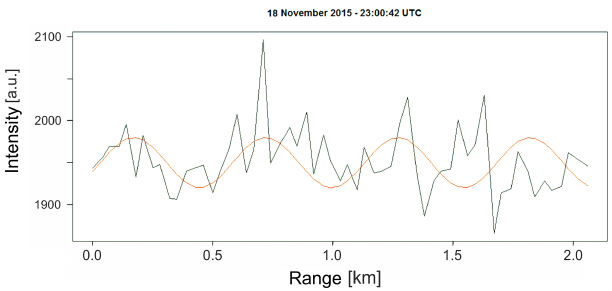
Figure 3. Measured intensities along a cross section perpendicu- lar to the wavefronts (its position is indicated by the black line in Fig. 2b) in the image of 18 November 2015, 23:00:42UTC. The pixel range has been converted into kilometres. The orange line shows an ideal 550m wave (fitted by hand). Only the first half of the data series shows this signal, too.